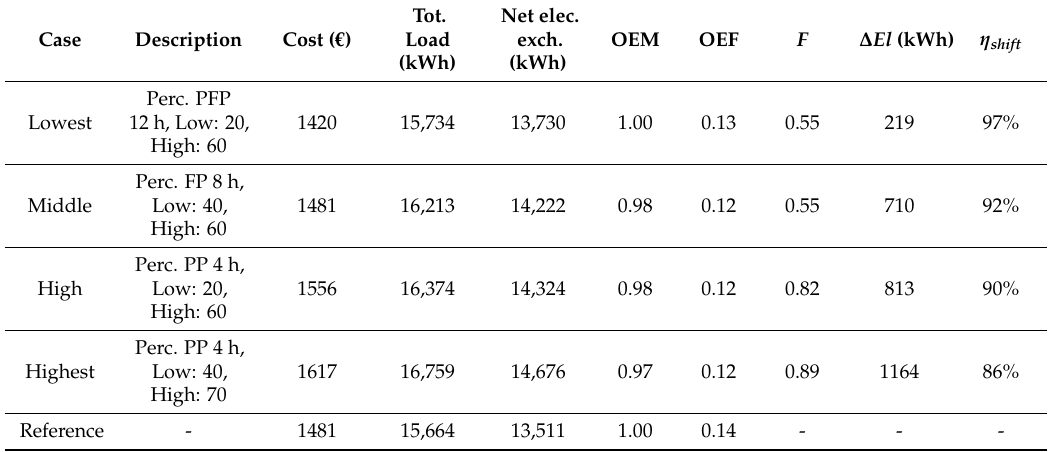
Table 5. The parameters and annual results for selected cases and for the reference